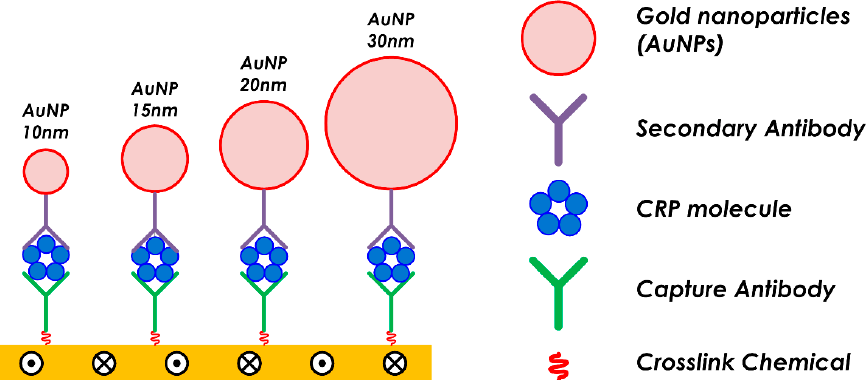
Figure 3. Schematic of the molecule structure with different gold nanoparticle diameters.